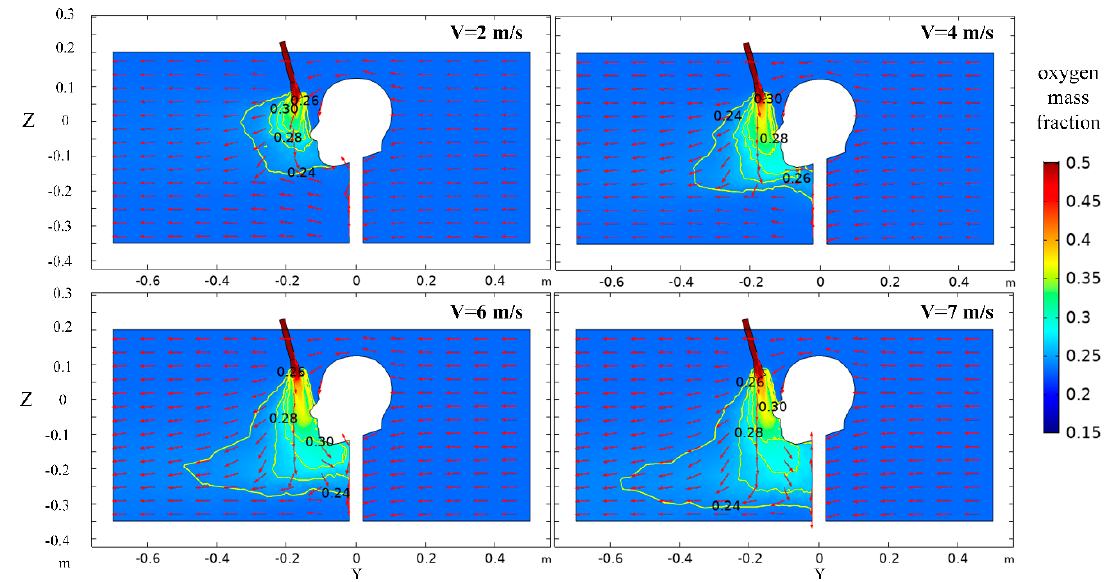
Figure8. DistributionofoxygenmassfractionintheX = 0msectionatdi ff Figure 8. Distribution of oxygen mass fraction in the X = 0 m section at different oxygen-supply velocities.